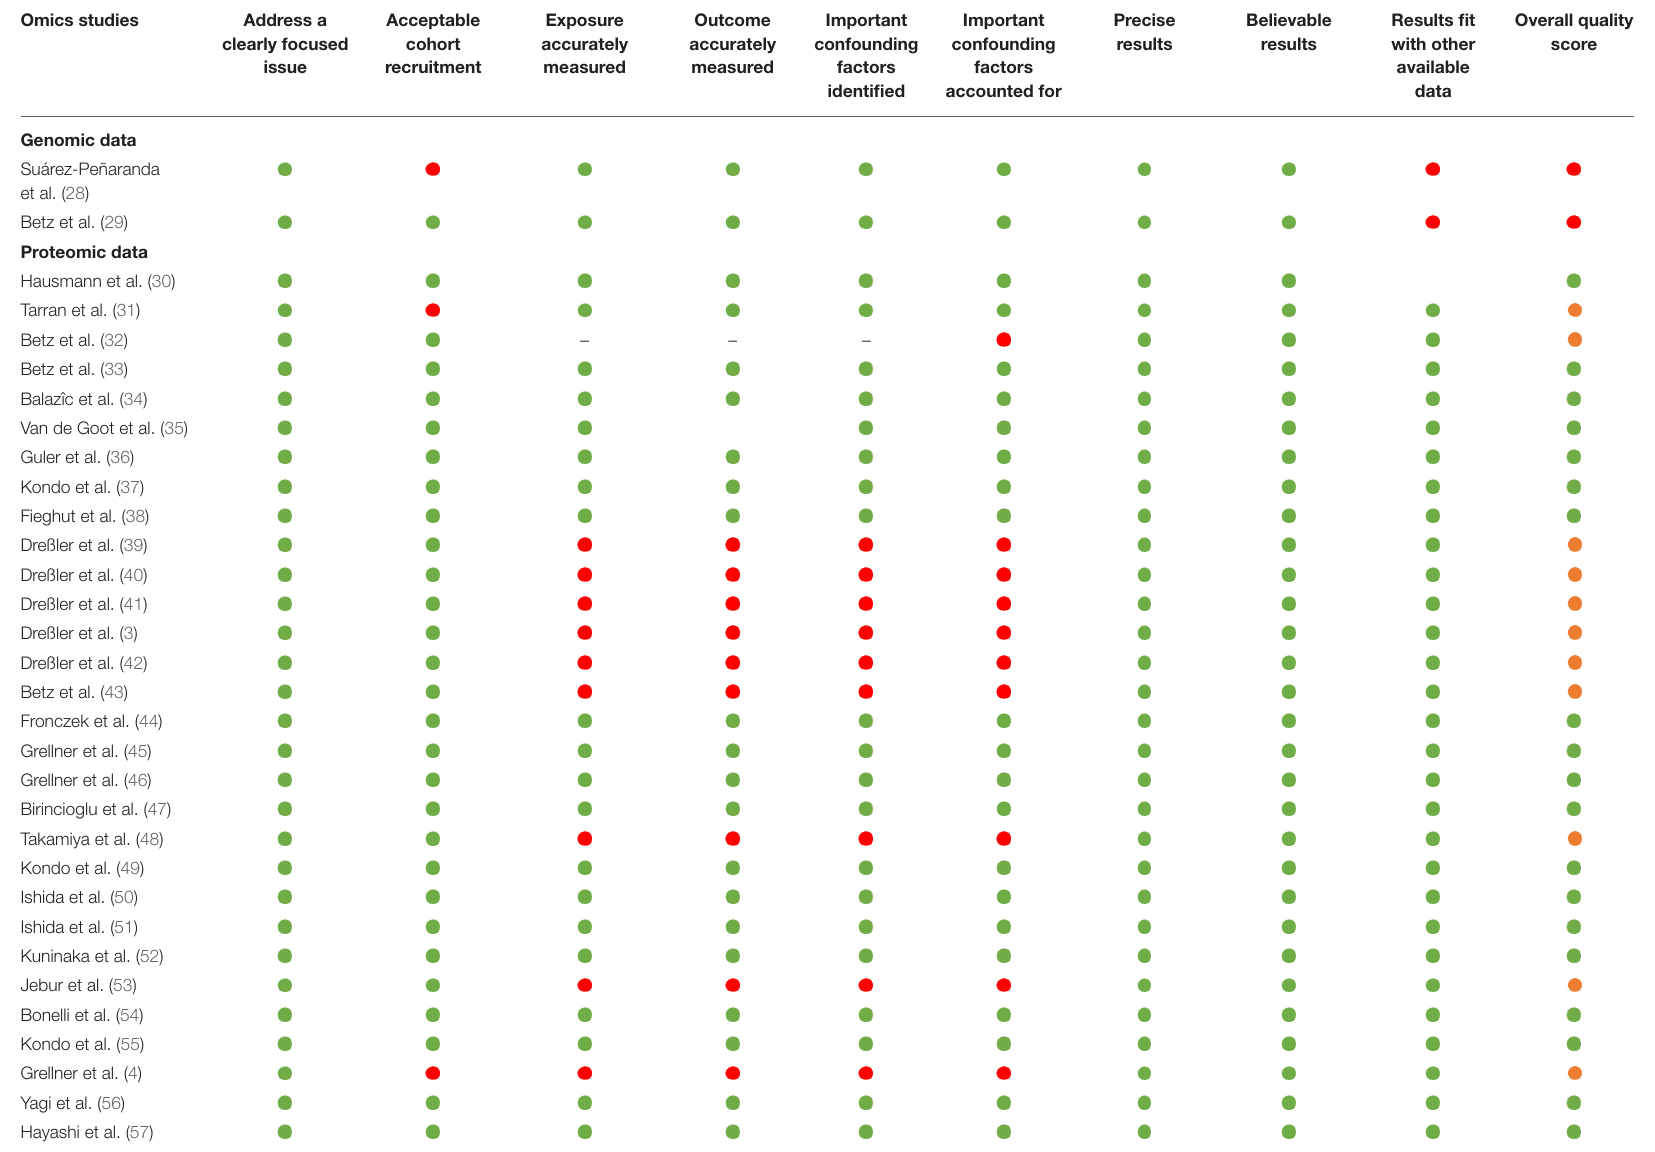
TABLE 1 | Risk of bias assessment: age of wounds a . Omics